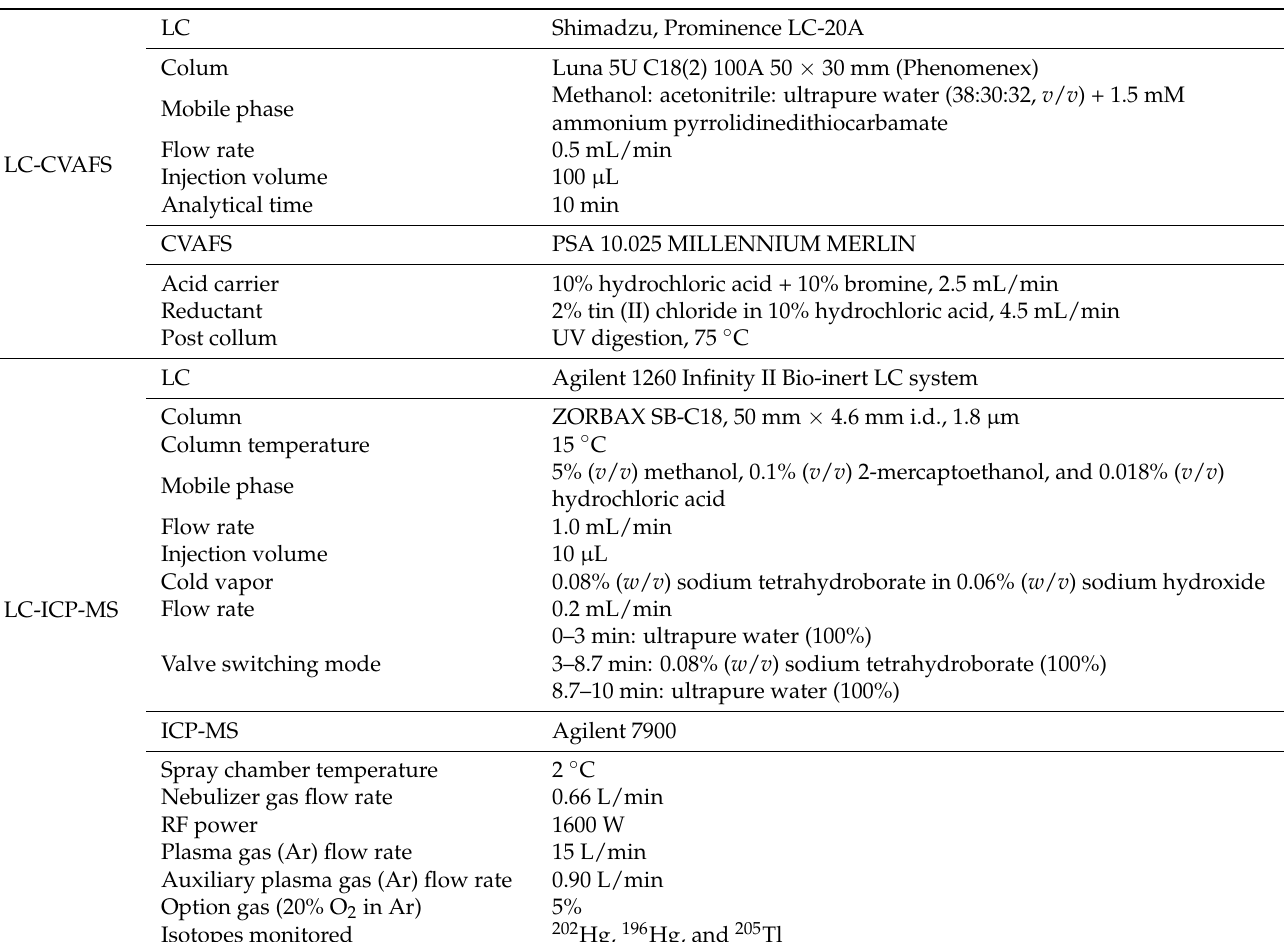
Table 1. Instrument setting for LC-CVAFS and